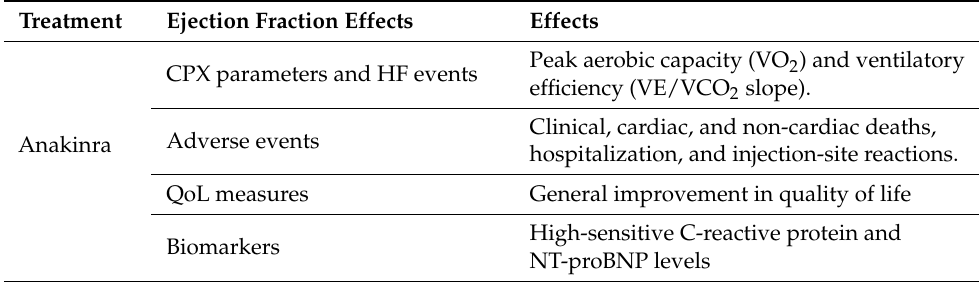
Table 1. Outcomes studied in the trials of use of anakinra in heart failure.